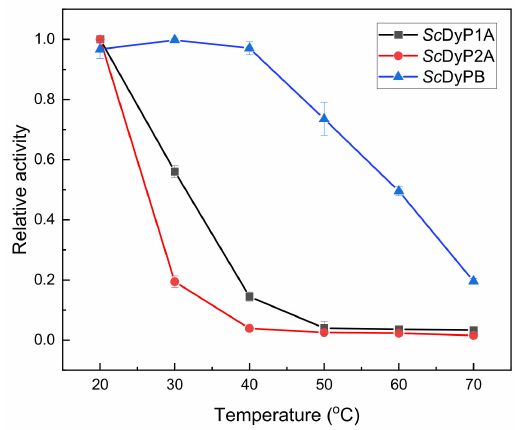
Figure 3. The temperature dependency of Sc DyPs. Peroxidase activity was measured at pH 3.5 (50 mM sodium citrate) using ABTS as substrate. 1 mM H 2 O 2 was used as a co-substrate. Experiments were conducted in triplicate.